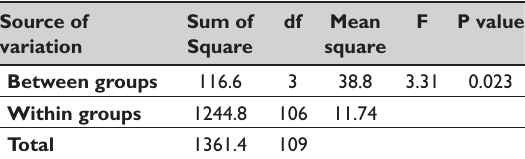
Table 6: Relationship between Respondent’s Knowledge and Years of Service Source of variation